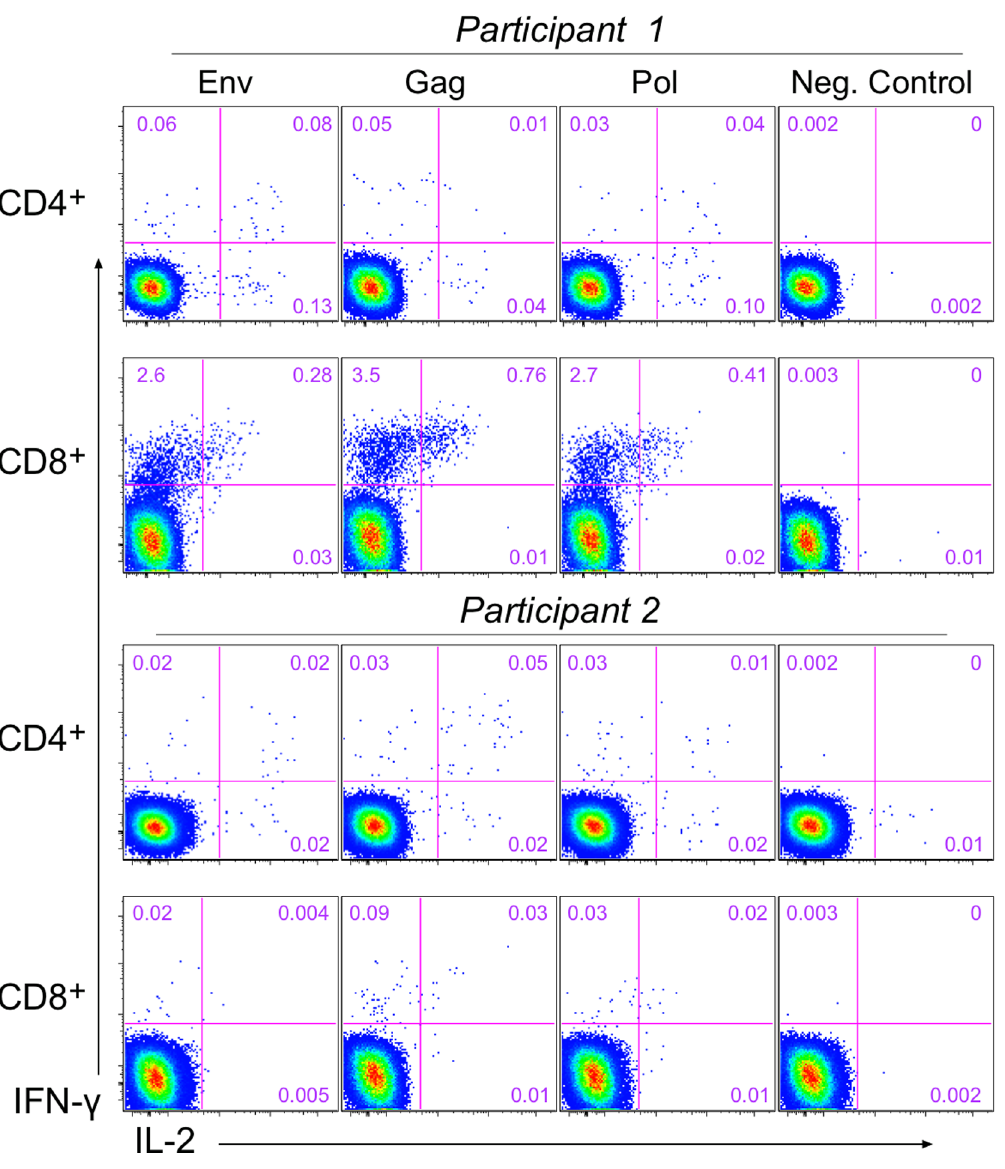
Figure 4. Staining profiles for ICS analysis for two trial participants. The expression of IFN- c and IL-2 are shown for CD4 + and CD8 + T cells in response to stimulation with the first pools for Env, Gag, and Pol and for the negative control (peptide diluent, 1% DMSO) at day 28. Numbers on the plots are the percentages of CD4 + or CD8 + T cells producing the cytokine or combination of cytokines. Participant 1 represents an example of a high CD8 + T-cell response and Participant 2 represents low CD4 + and CD8 + T-cell responses. All responses are positive as tested for cells producing IFN- c and/or IL-2 except for Env and Pol for participant 2. Both participants were in the 10 11 PU dose group.